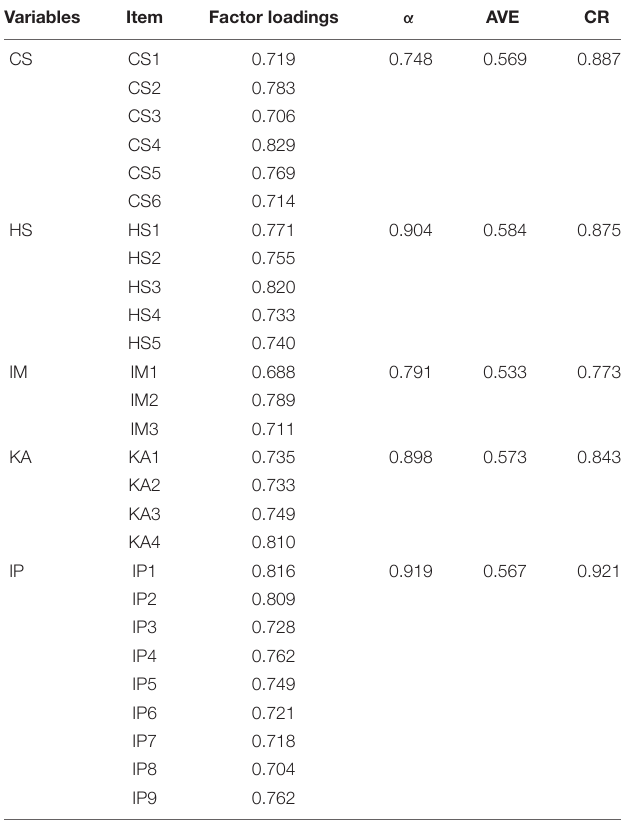
TABLE 2 | Results for reliability and